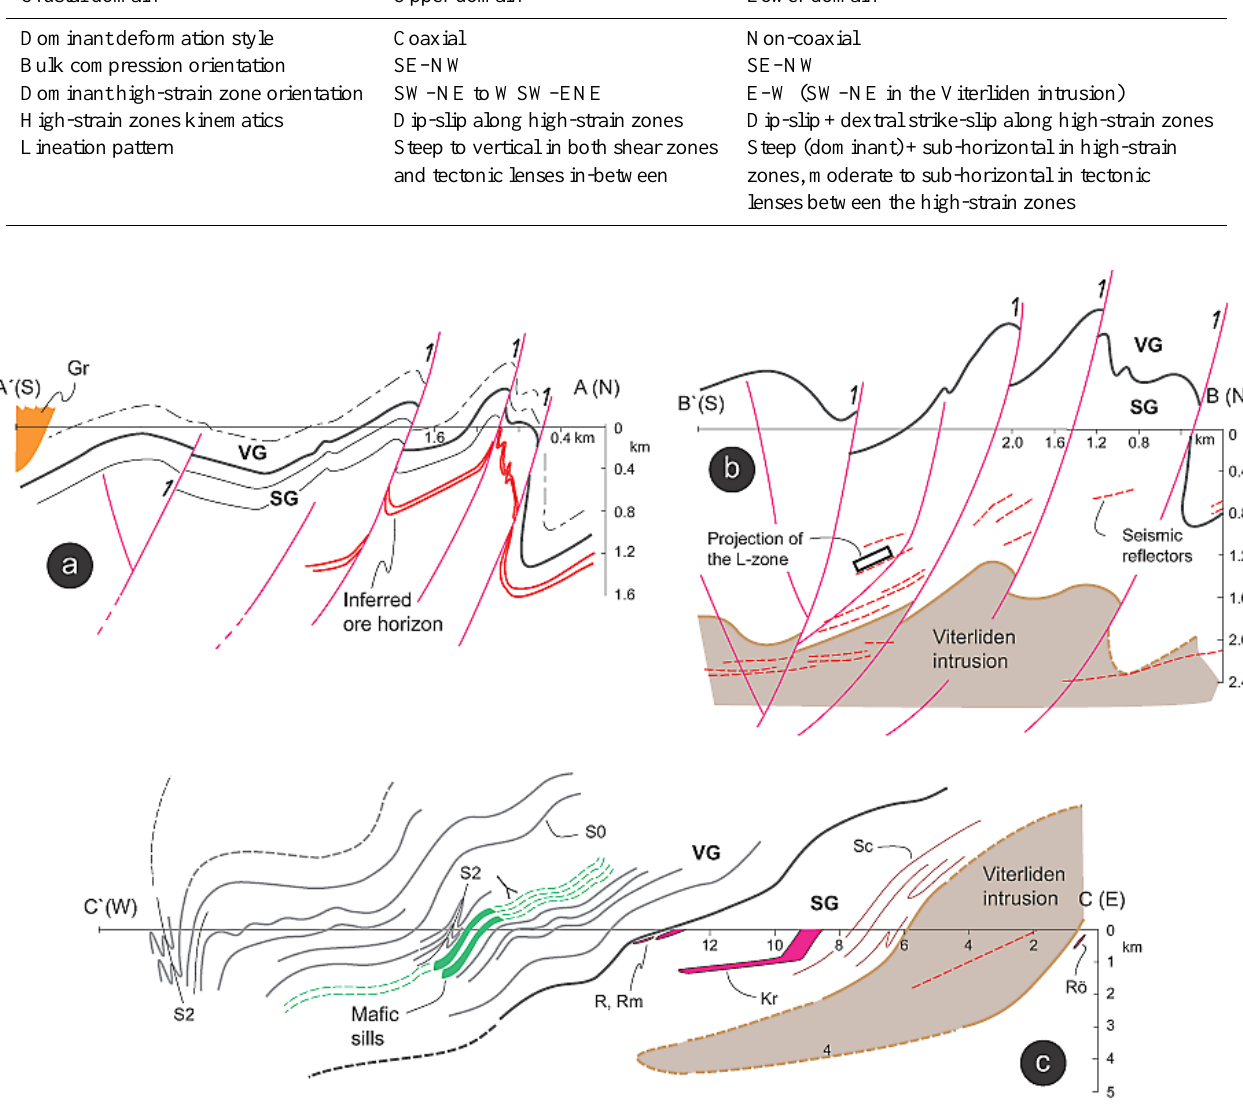
Fig. 5. Geological cross sections, see Fig. 2a for location. (a) Cross section through the contact zone between the metavolcanic and metased- imentary rocks, Gr: late-orogenic granite, SG: Skellefte Group, VG: Vargfors Group, (b) Cross section along the “high-resolution” seismic profile in Fig. 4c (Dehghannejad et al., 2010). (c) Longitudinal E–W cross section. The section is parallel to the E–W seismic line in Fig. 4d but extends further both towards E and W. Abbreviations for ore deposits as in Fig.